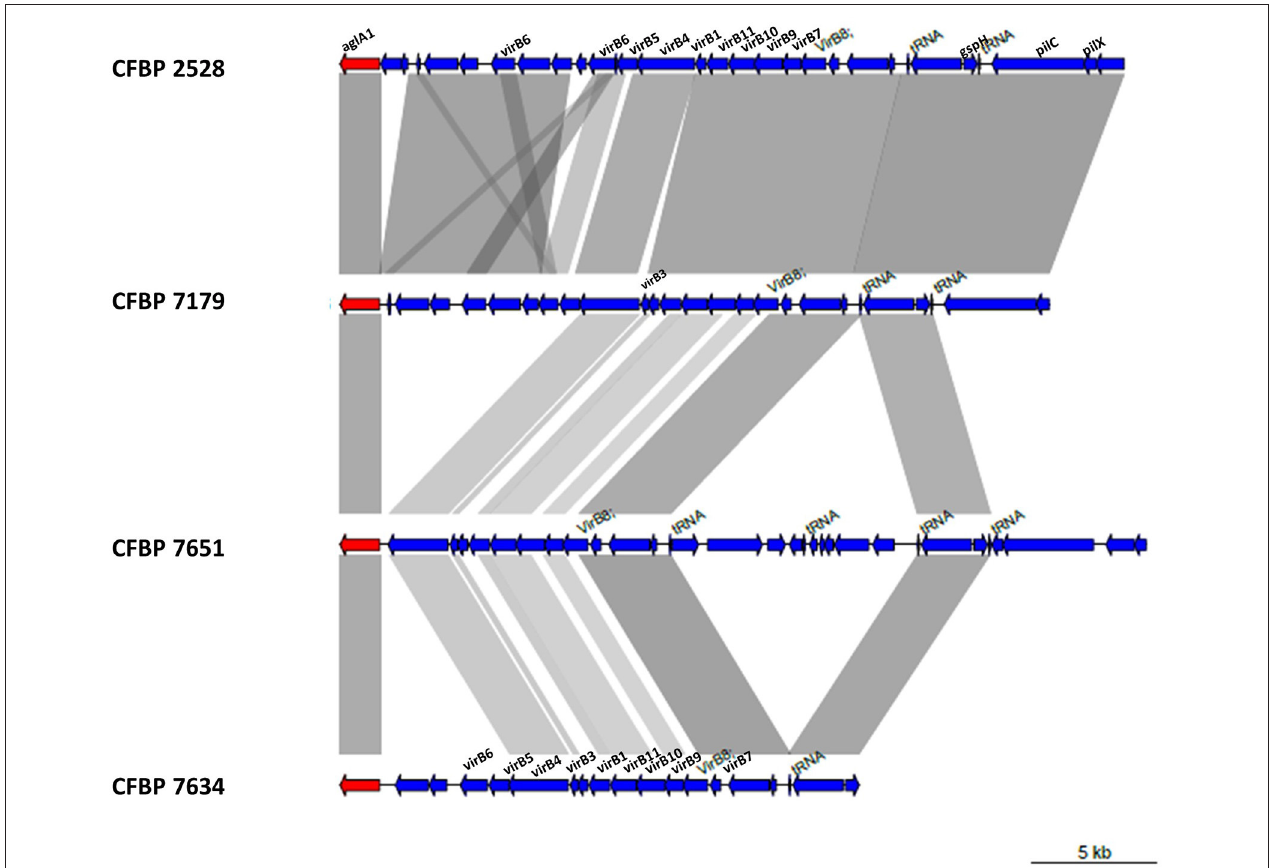
FIGURE 9 | Schematic representation of T4SS genes of the four X. arboricola strains.